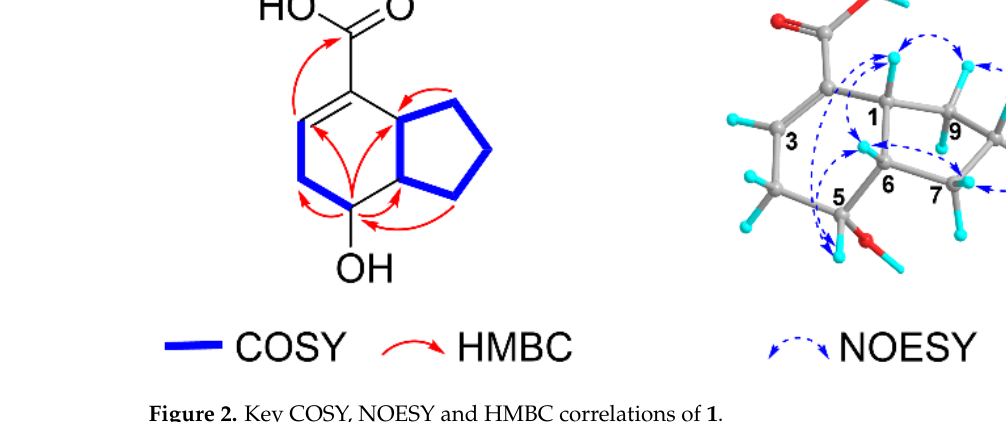
Table 1. 1 H (400 MHz) and 13 C (100 MHz) NMR data for 1 and 2 .